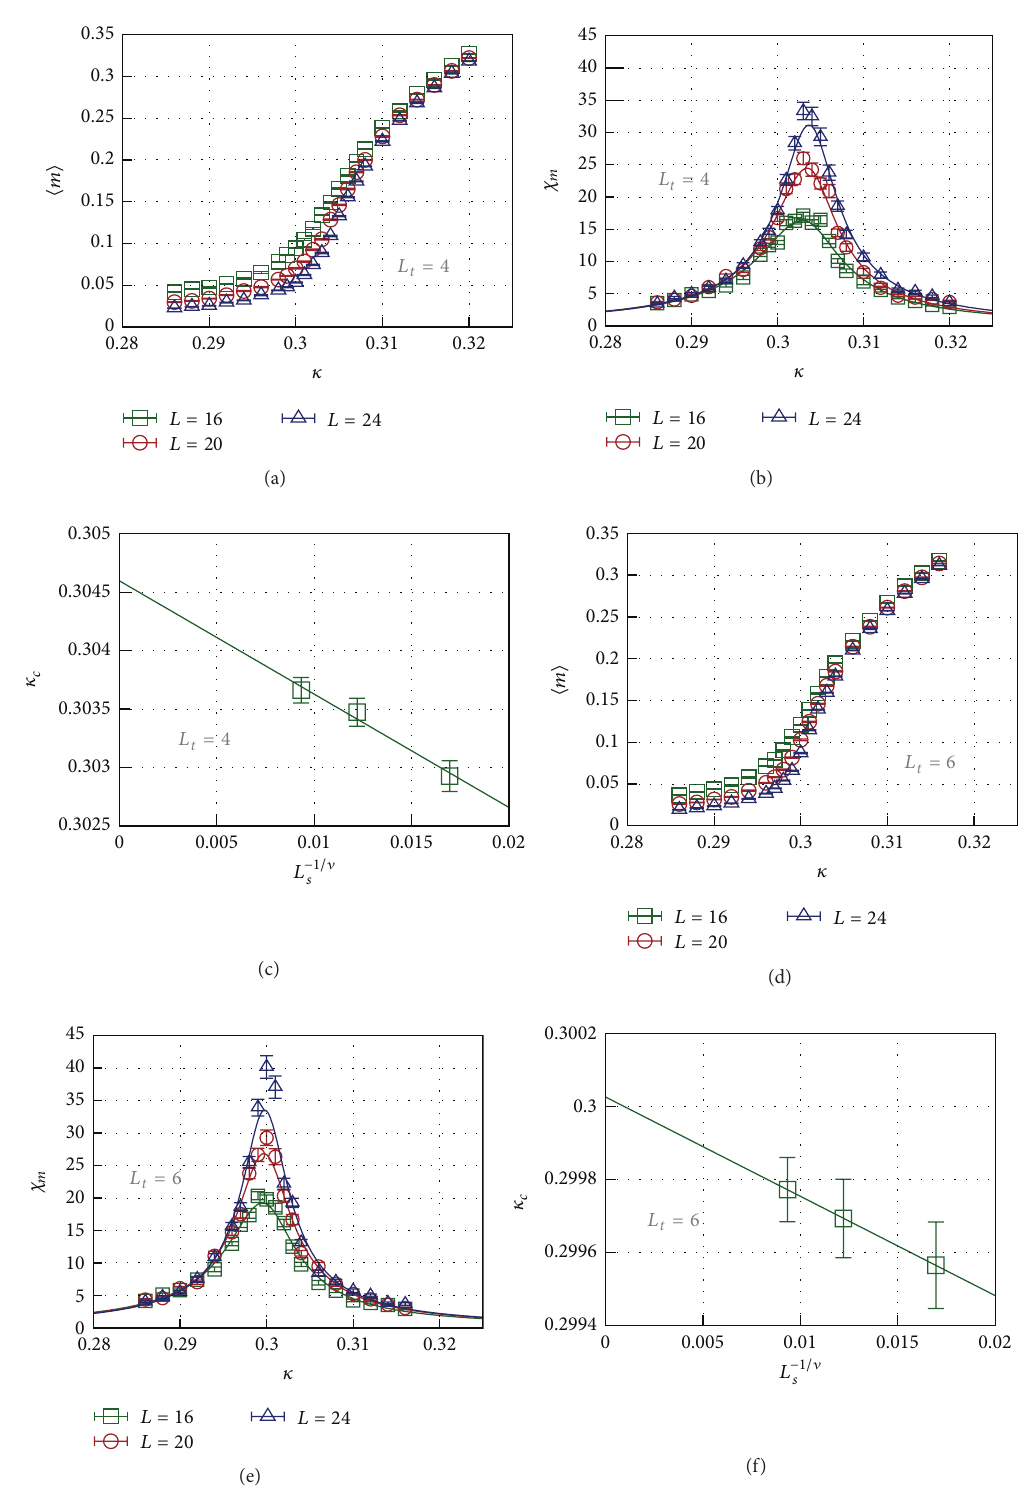
̂ 𝜆 = ∞ . Plots (a) and (d): the